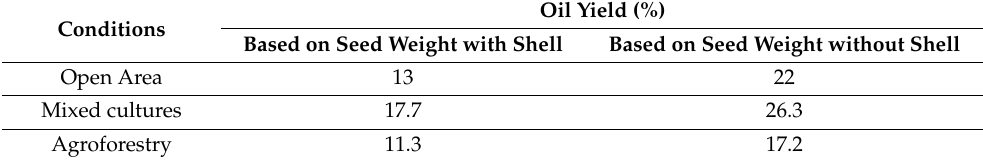
Table 4. Sacha Inchi oil yield.